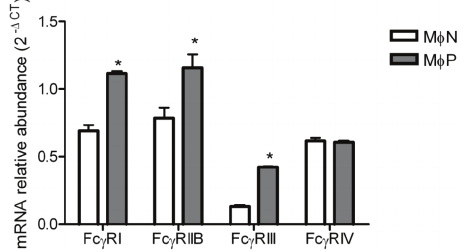
Figure 7. Fc γ Rs mRNA expression in M φ N and M φ P. Total RNA from M φ N and M φ P cells was harvested and converted to cDNA, and mRNAs for Fc γ RI, RIIB, RIII and RIV were measured by real-time PCR. Transcript levels were normalized to GAPDH mRNA expression. Data are expressed as 2 −Δ CT . Results are shown as mean ± 1 SD from three independent experiments using cells from passages 72, 83 and 87, * indicates p <